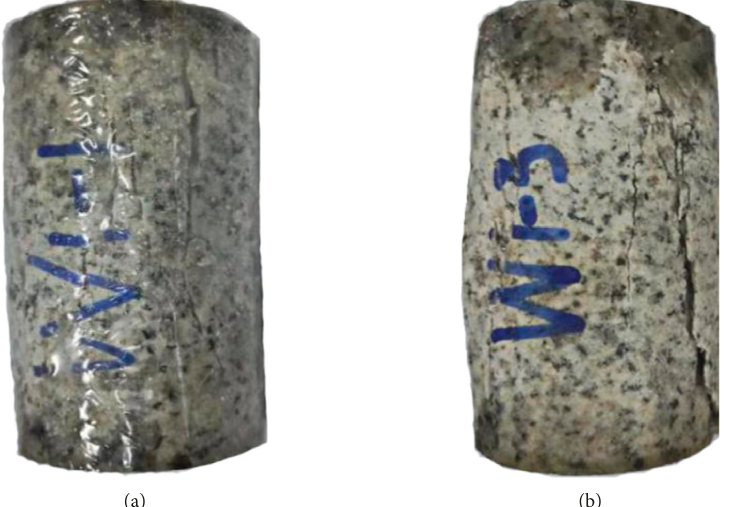
Figure 5: Comparisons of failure modes of samples under uniaxial compression. (a) Monotonic loading. (b) Cyclic loading.